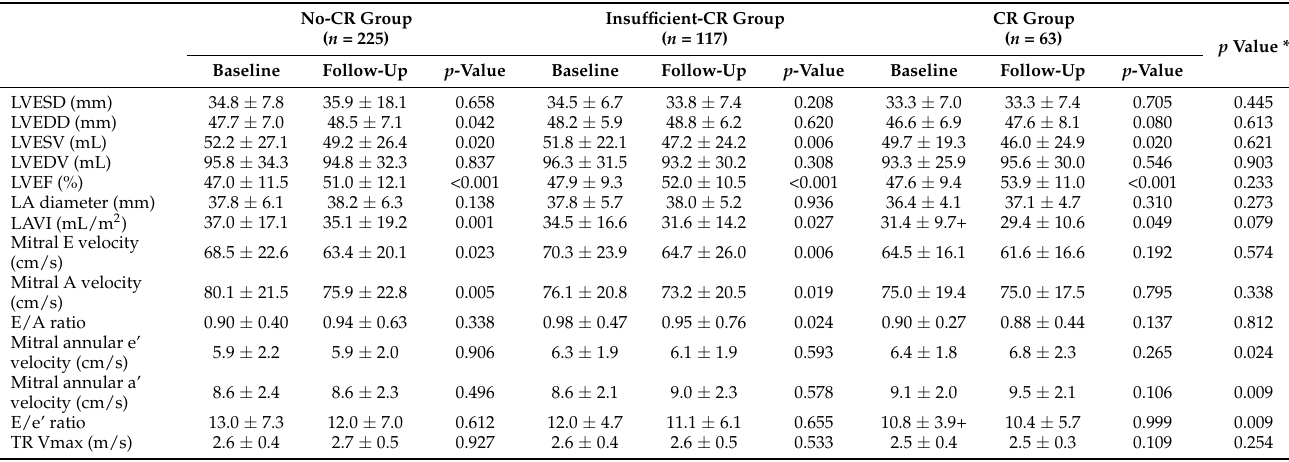
Table 2. Comparison of baseline and follow-up echocardiographic findings according to the presence of cardiac rehabilita- tion (CR).